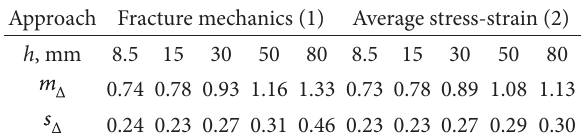
Table 2. Basic statistics (sample mean and standard deviation) derived for both tension-stiffening